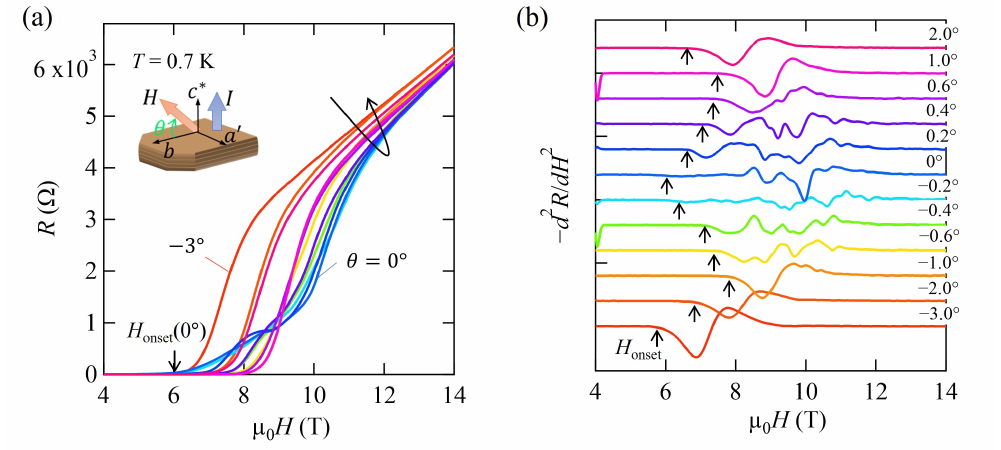
Figure 6. ( a ) Magnetic field dependence of the resistance at various field angles θ . Definition of θ is in the inset. ( b ) Negative second-derivative curves of the resistance. Each curve is shifted for